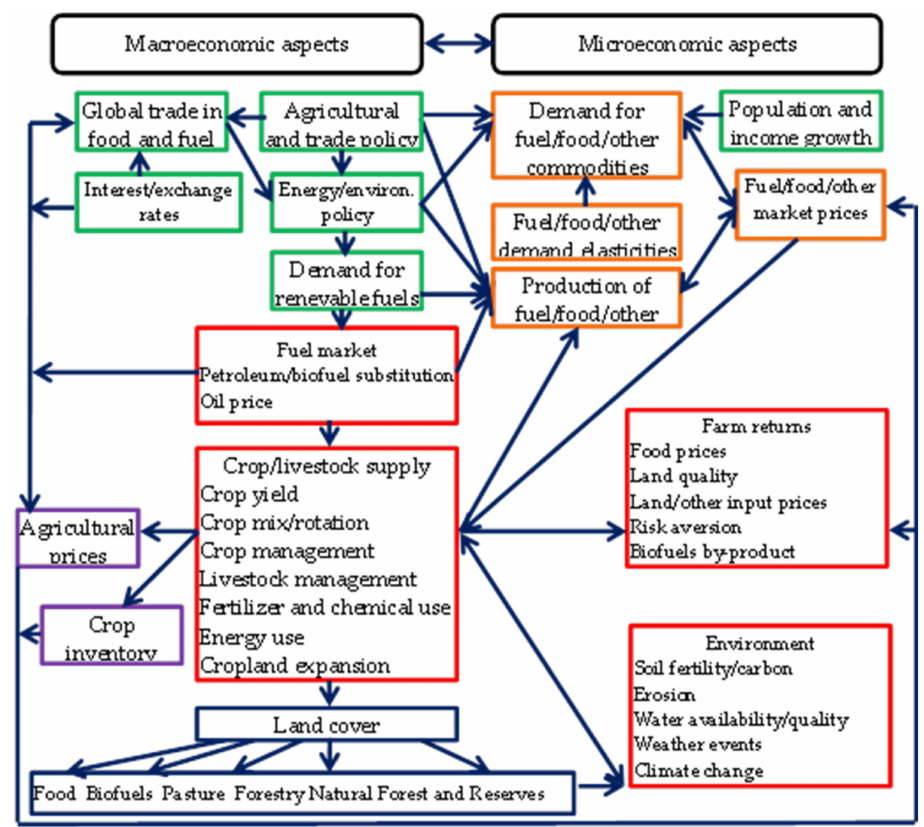
Figure 2. Biofuel-food market interactions.